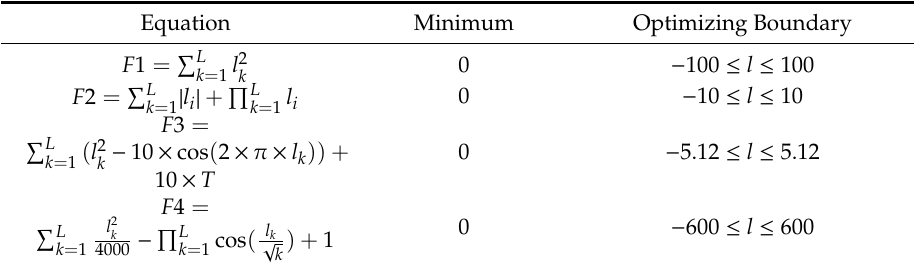
Table 1. Standard optimization functions.